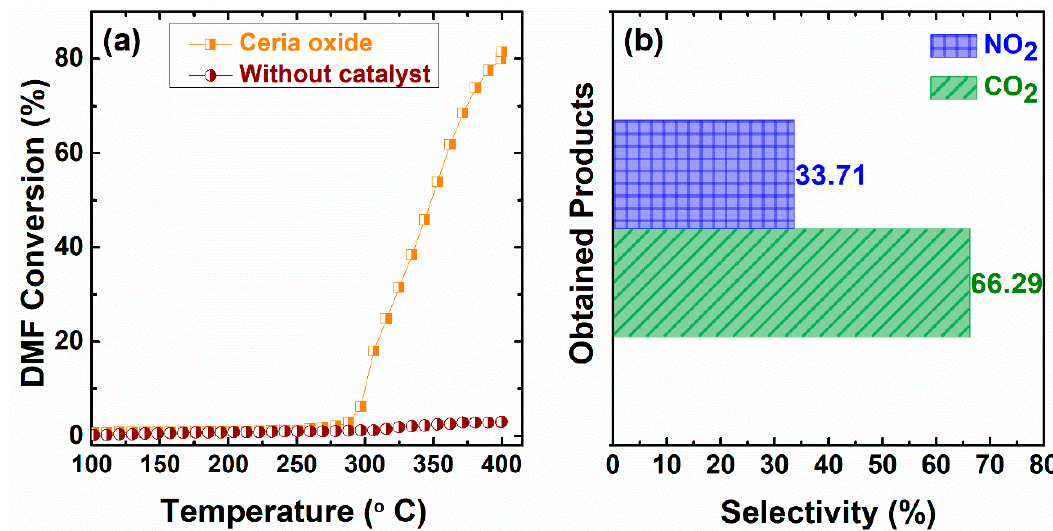
Figure 7. Conversion of DMF oxidation on the catalyst ( a ) and selectivity of the obtained product ( b ).